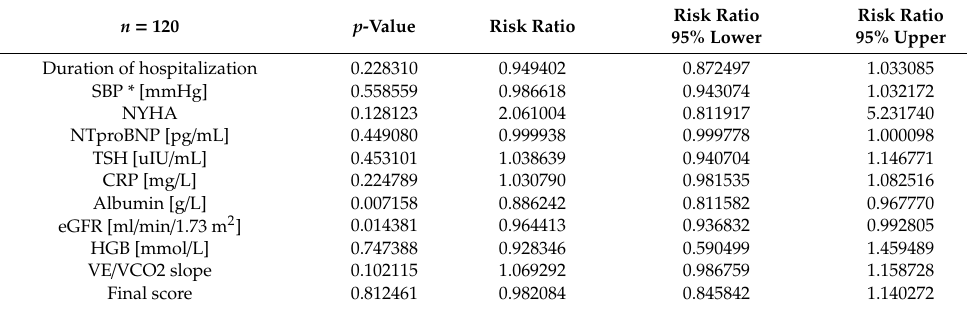
Table 5. Analysis of nutritional